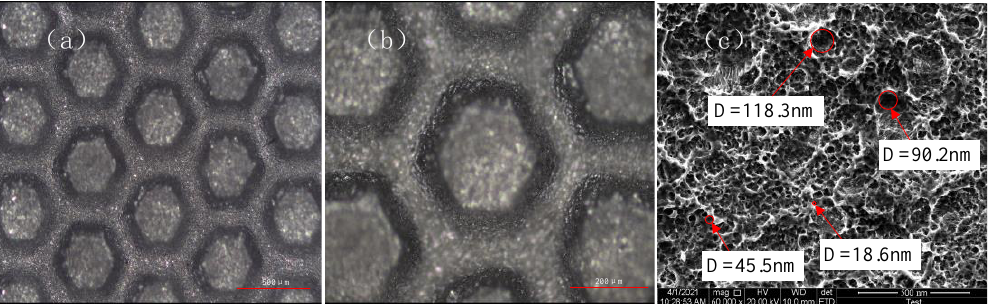
Figure 19. Optical microscope images ( a , b ) and SEM images ( c ) of the boss after laser and acid etch- ing.